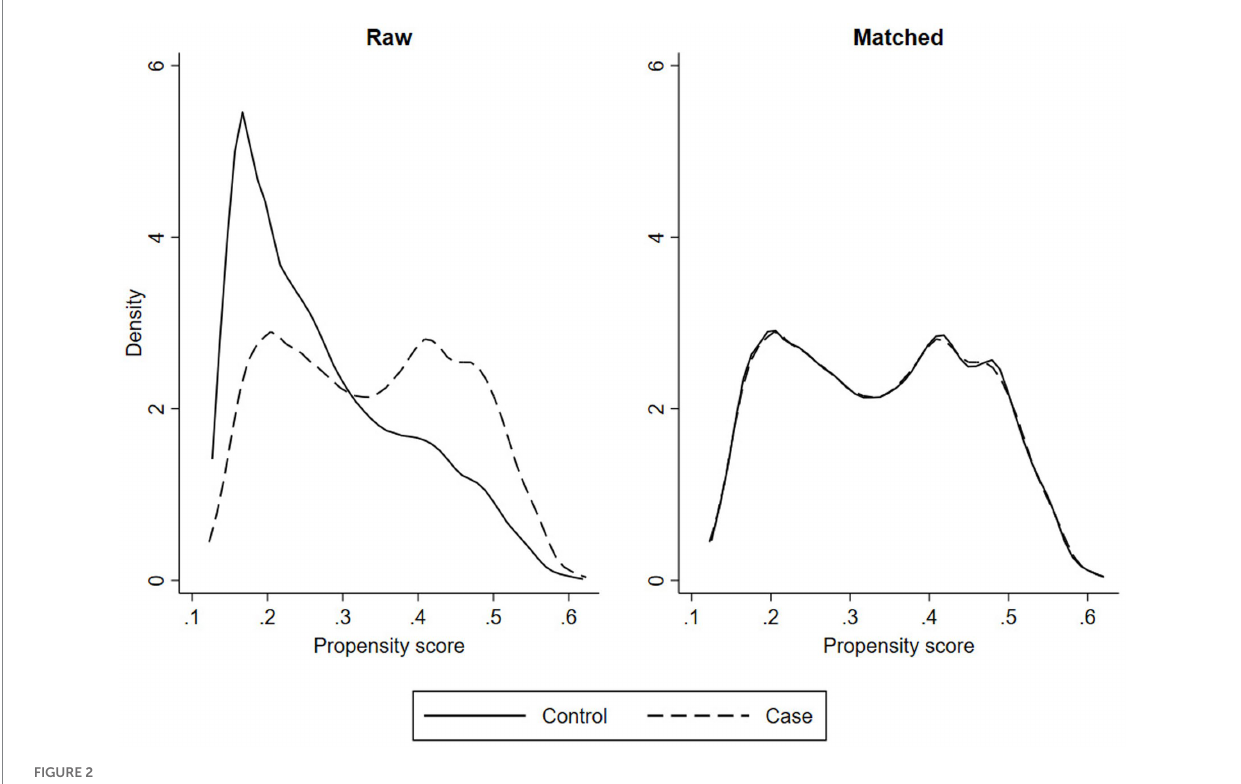
FIGURE 2 Non-parametric density plots.